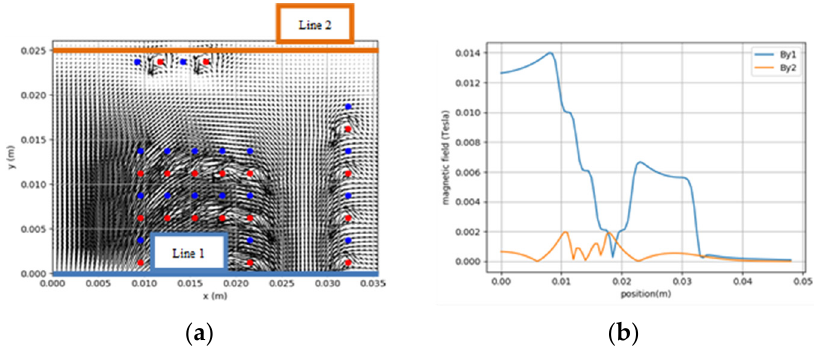
Figure 8. Open-circuit test: ( a ) Studied lines of magnetic field; ( b ) Magnetic field.